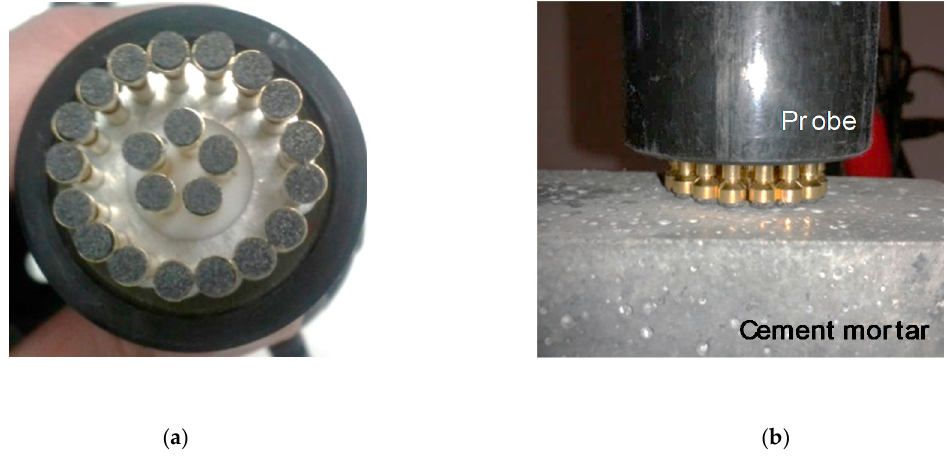
Figure 5. ( a ) Pinelectrodearrangementinheadofcustomelectricalprobeand( b Figure 5. ( a ) Pin electrode arrangement in head of custom electrical probe and ( b ) Sample and probe during resistivity measurement.